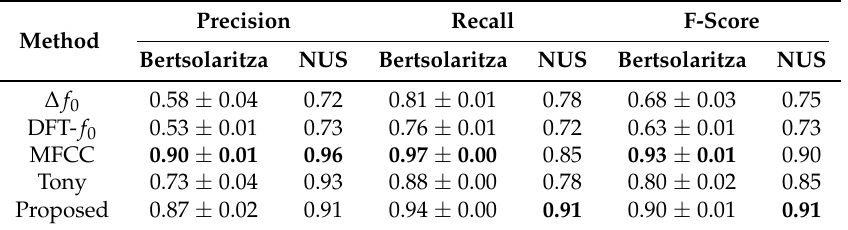
Table 5. Results of speech classification.